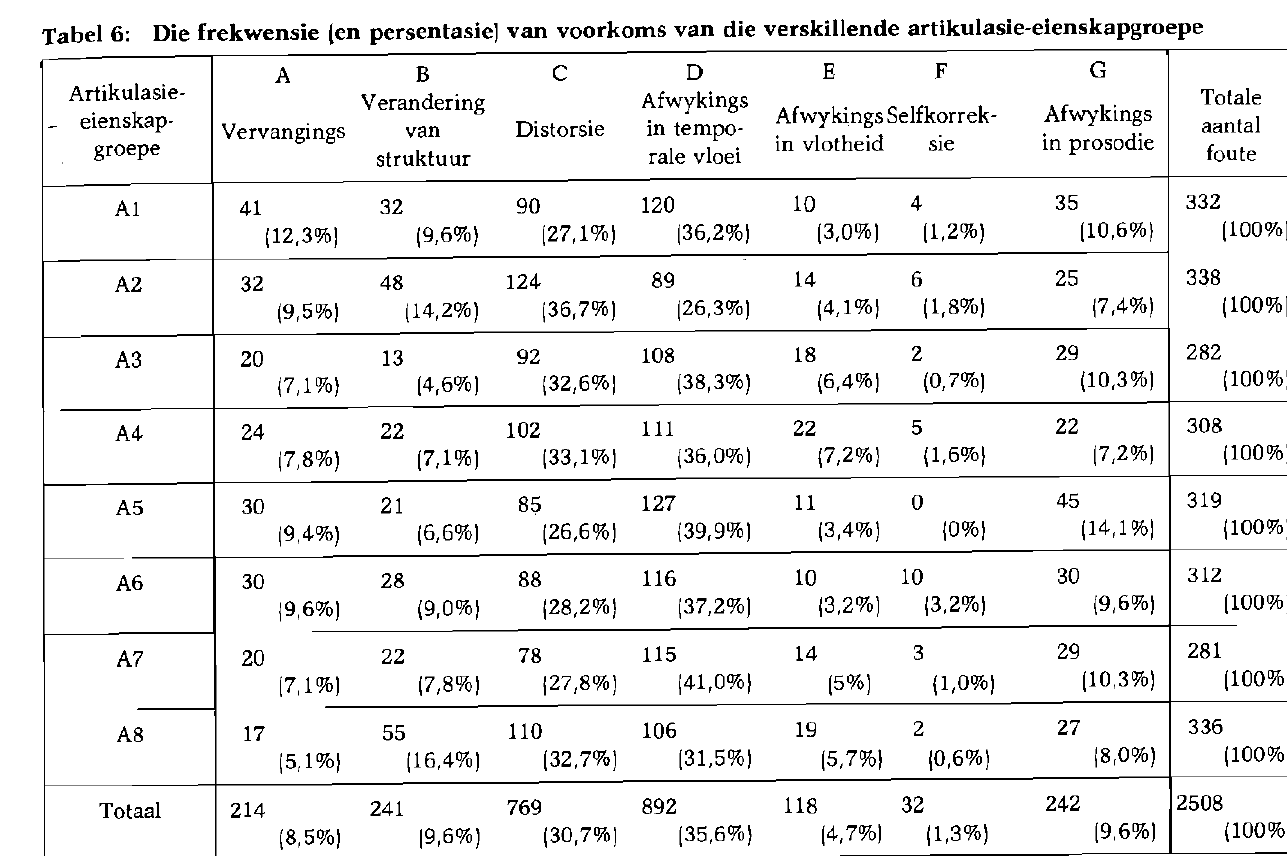
Tabel 6: Die frekwensie (en persentasie) van voorkoms van die verskillende artikulasie-eienskapgroepe Artikulasie-